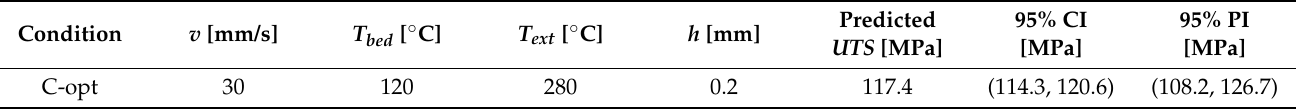
Figure 8. Distribution of UTS values for specimens 3D-printed with the optimal parameter combi- nation, according to the DoE prediction model. Confidence and prediction intervals are delimited according to Table 5.